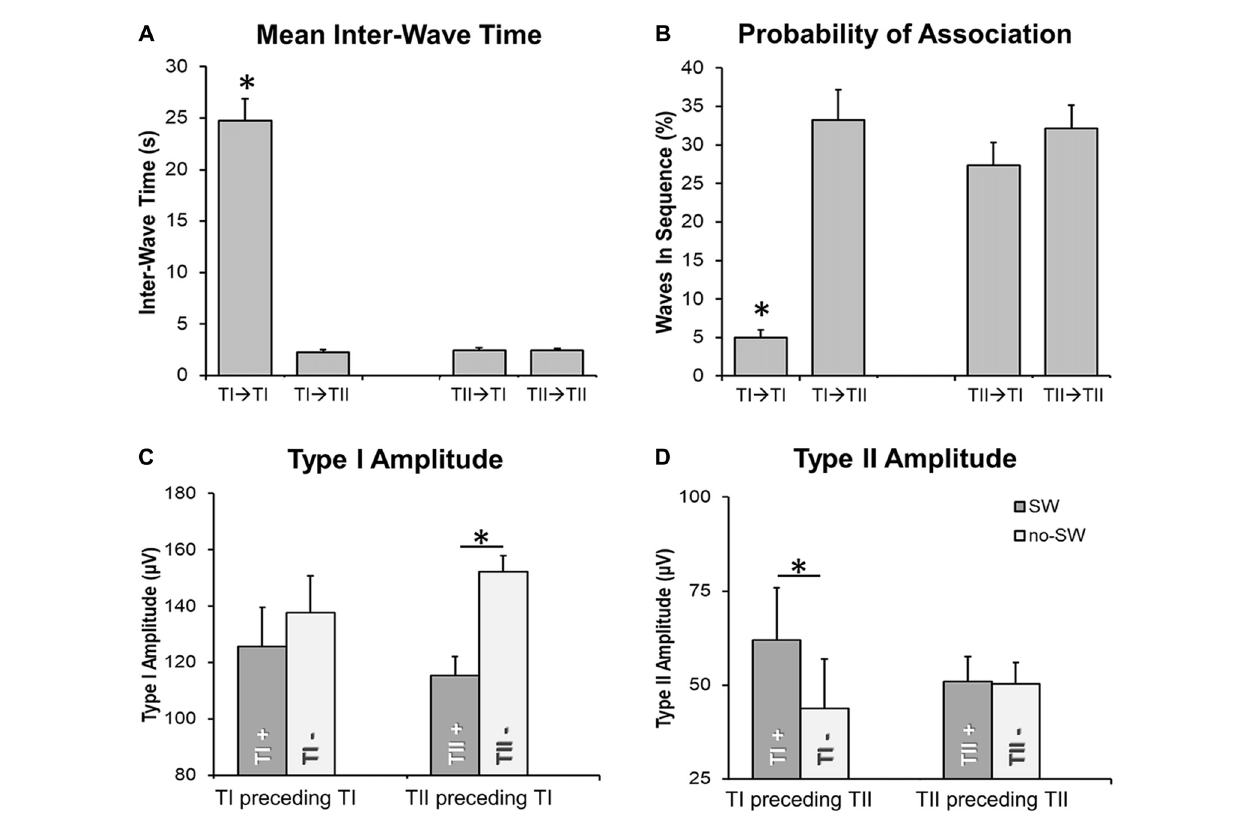
FIGURE 6 | Temporal relationship between slow waves. Barplots in (A,B) show that the delay between two type I slow waves is typically longer than the delay between type I and type II slow waves or between two type II slow waves. Barplots in (C,D) depict the effect of the “presence” (TI+, TII+; vs. “absence,” marked with TI- or TII-) of a slow wave on the amplitude of a subsequent, associated type I (TI) or type II (TII) slow wave. Two waves were defined as associated if the distance between the end of the preceding half-wave and the beginning of the following negative deflection was < 1 s. The ∗ marks significant differences at corrected p < 0.05 (when placed above a single bar, the ∗ marks difference between a specific condition and all other examined conditions). Vertical bars indicate